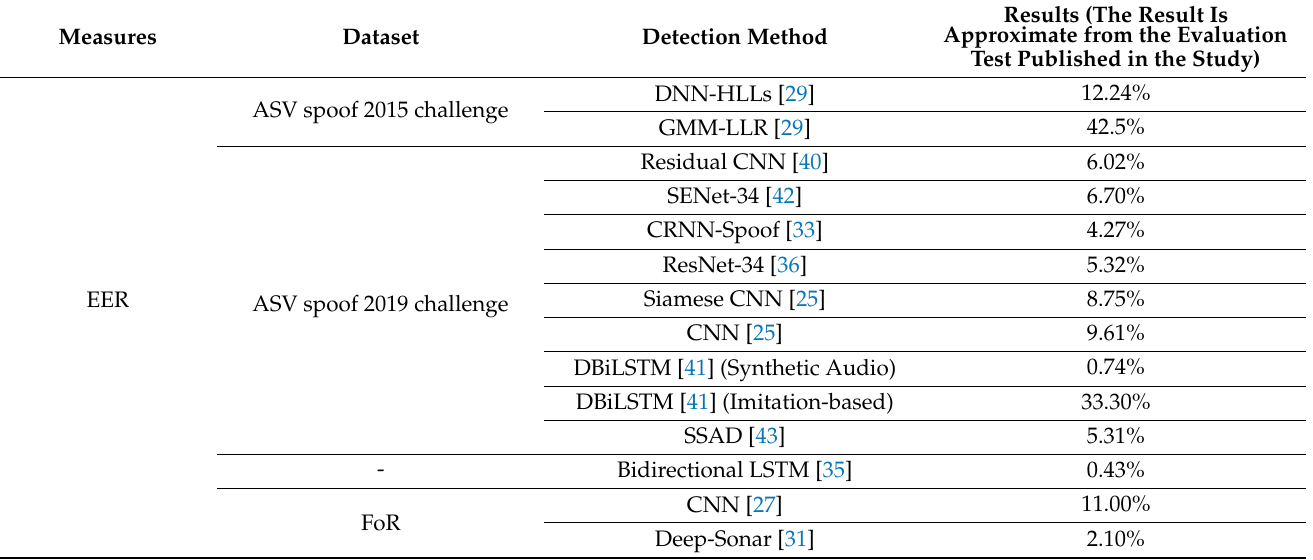
Table 3. A quantitative comparison between AD detection